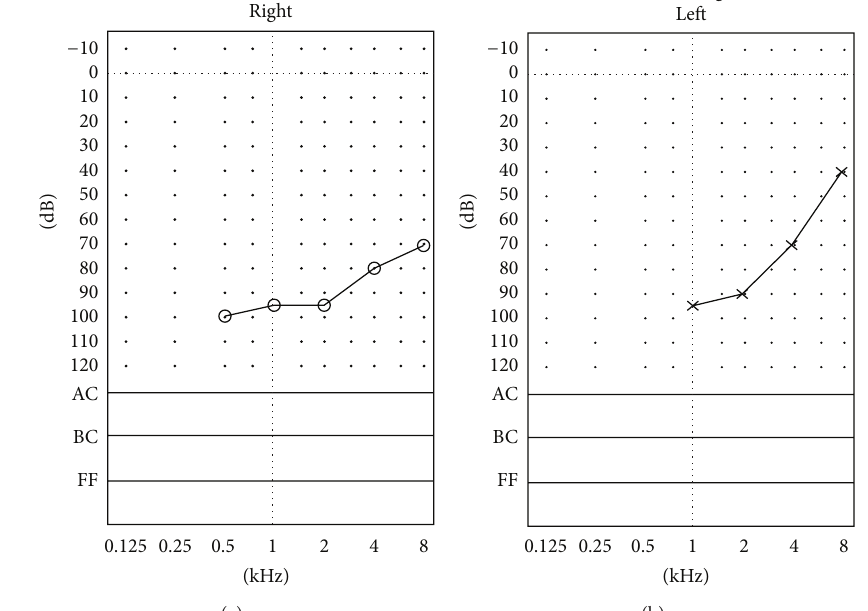
person, body reserve of thiamine is sufficient for up to 18 days. If not supplemented, thiamine storage usually depletes in 2-3 weeks. Within 4 days of deficiency, cytotoxic edema in brain sets in, and after 7–10 days, vasogenic edema and breakdown of BBB occur due to endothelial cell dysfunction, nitrous oxide production and glutamate release. Irreversible neuronal necrosis occurs after 2 weeks due to breakdown of neuronal DNA and lactic acid production